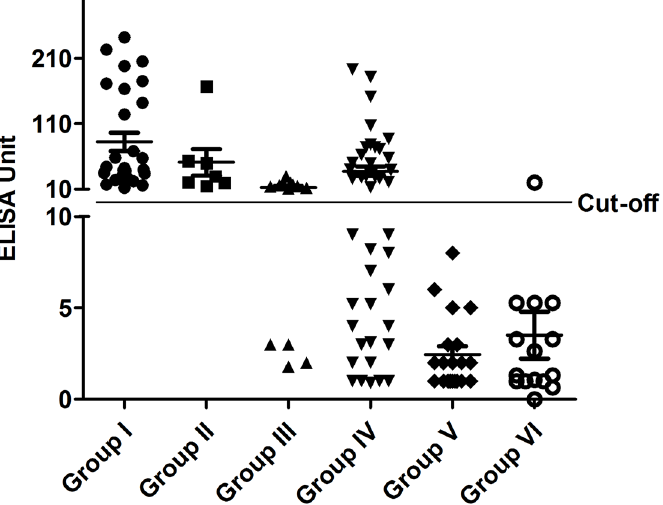
positive; Group II, four-fold change of Widal titre; Group III, Widal titer of (cid:1) 320; Group IV, blood culture and Widal test negative; Group V, healthy endemic zone control; Group VI, other febrile